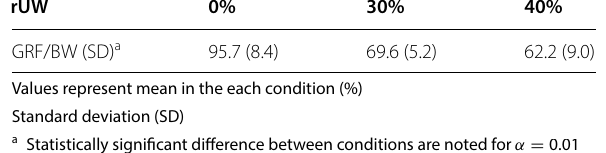
Table 1 Maximum vertical GRF/BW